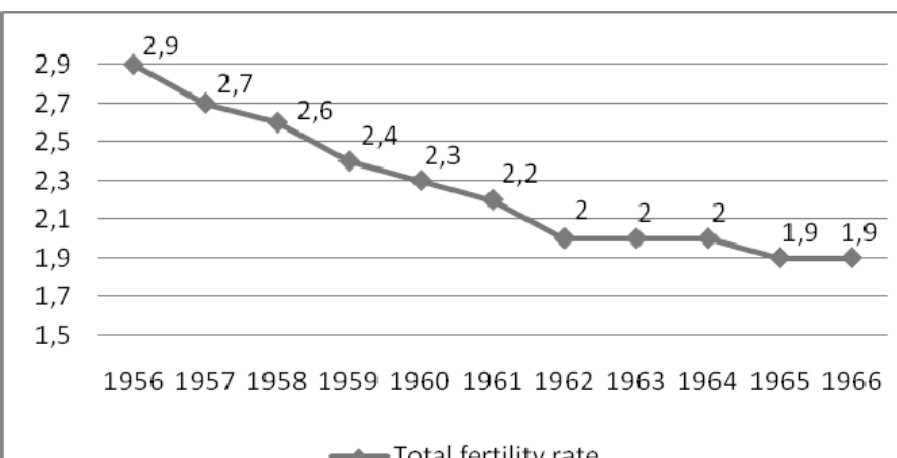
Source: National Institute of Statistics, Romanian Demographic Yearbook, 2006: